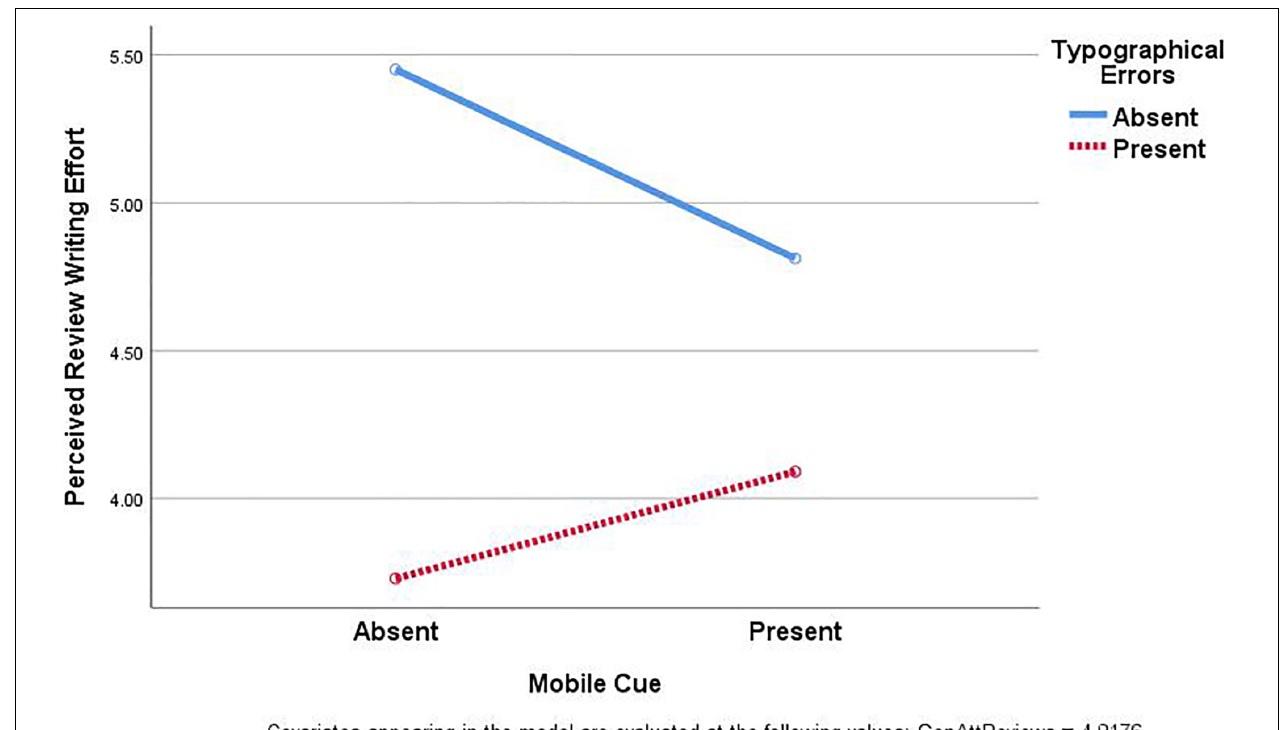
FIGURE 2 | Interaction between mobile cue and typographical errors on perceived review writing effort.